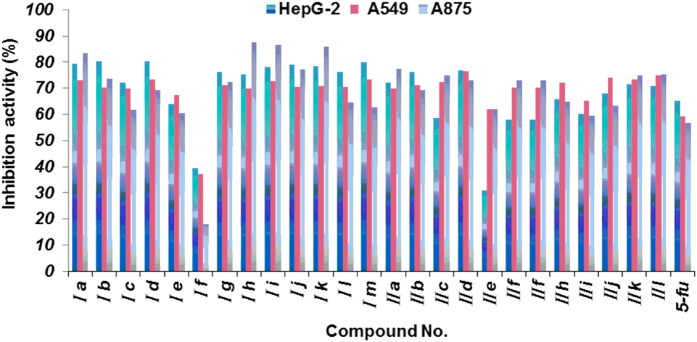
Inhibition activities against cell proliferation for target compounds at 40 μg/mL.Abbreviations: HepG2 - Human hepatocellular liver carcinoma cell line; A549 -Human lung cell line; A875 - Human melanoma cell line; 5-FU - 5-Fluorouracil, used as a positive control.